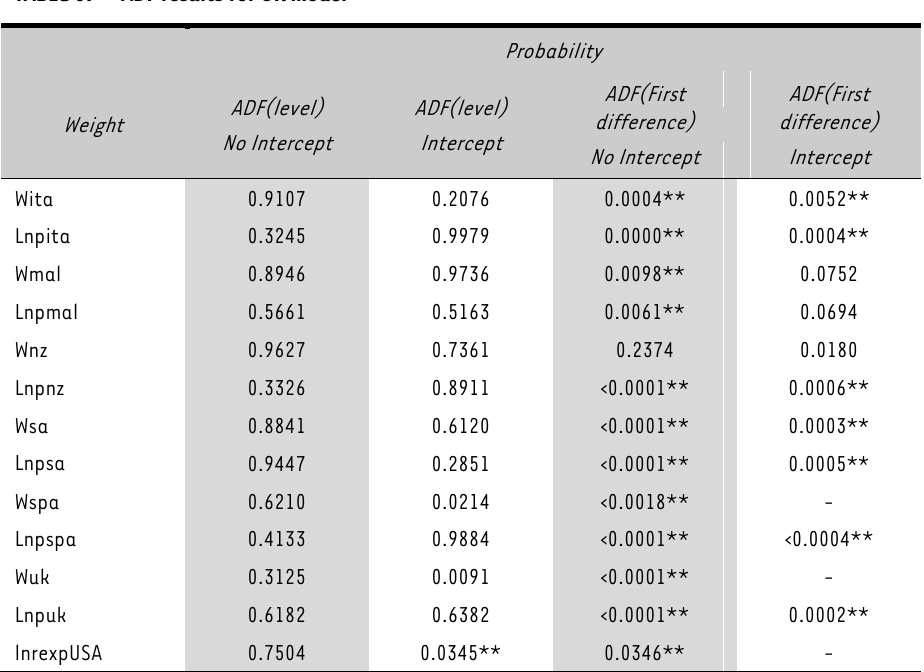
ADF results for UK